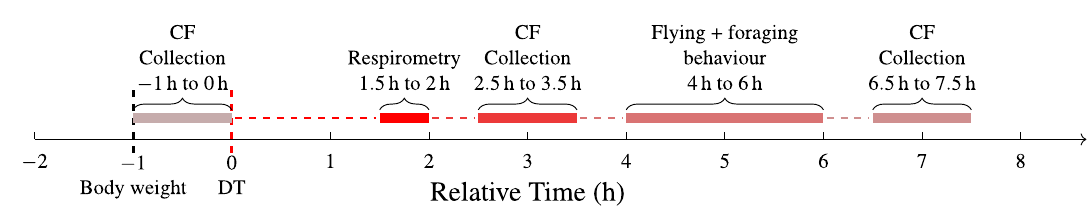
Figure 3. Daily experimental timeline for days 1 through 6 of trials where on days 1 through 3, a control solution (20% w/v sucrose solution) is given in all groups and on days 4 through 6, dosing solutions were administered. Times of data collection are shown relative to Dose Time (DT). Terminal tissue sampling occurred on day 7 at DT, 24 h after the final dose was